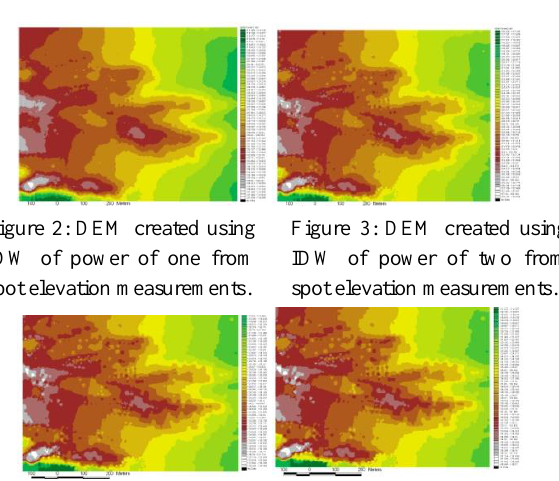
Figure 4: DEM created using IDW of power of three from spot elevation measurements.